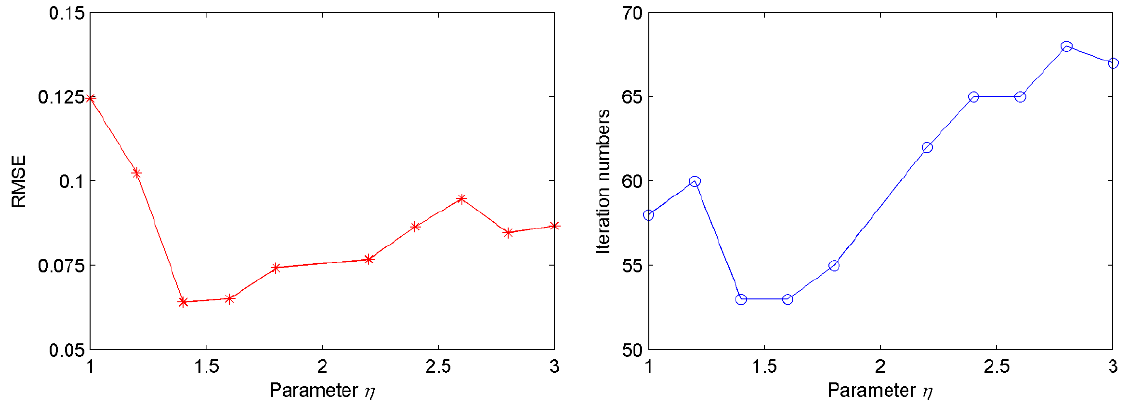
Figure 8. The influence of different η on the performance of proposed method.